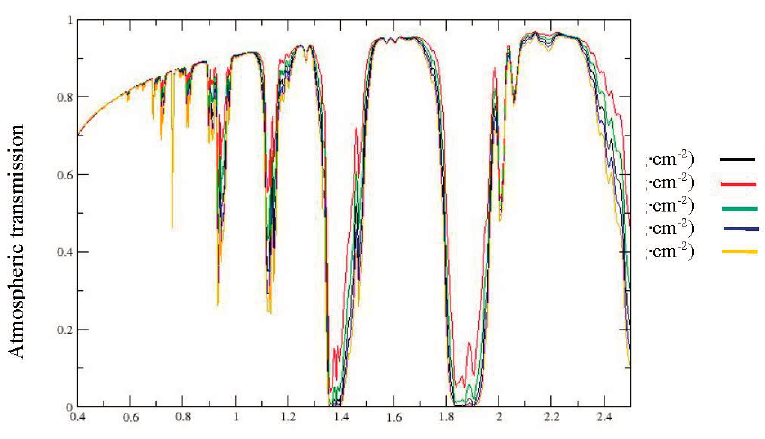
Figure 9. Total atmospheric transmission of the US standard profile for integrated vapour contents from 0.5 g·cm − 2 to 2.5 g·cm − 2 .